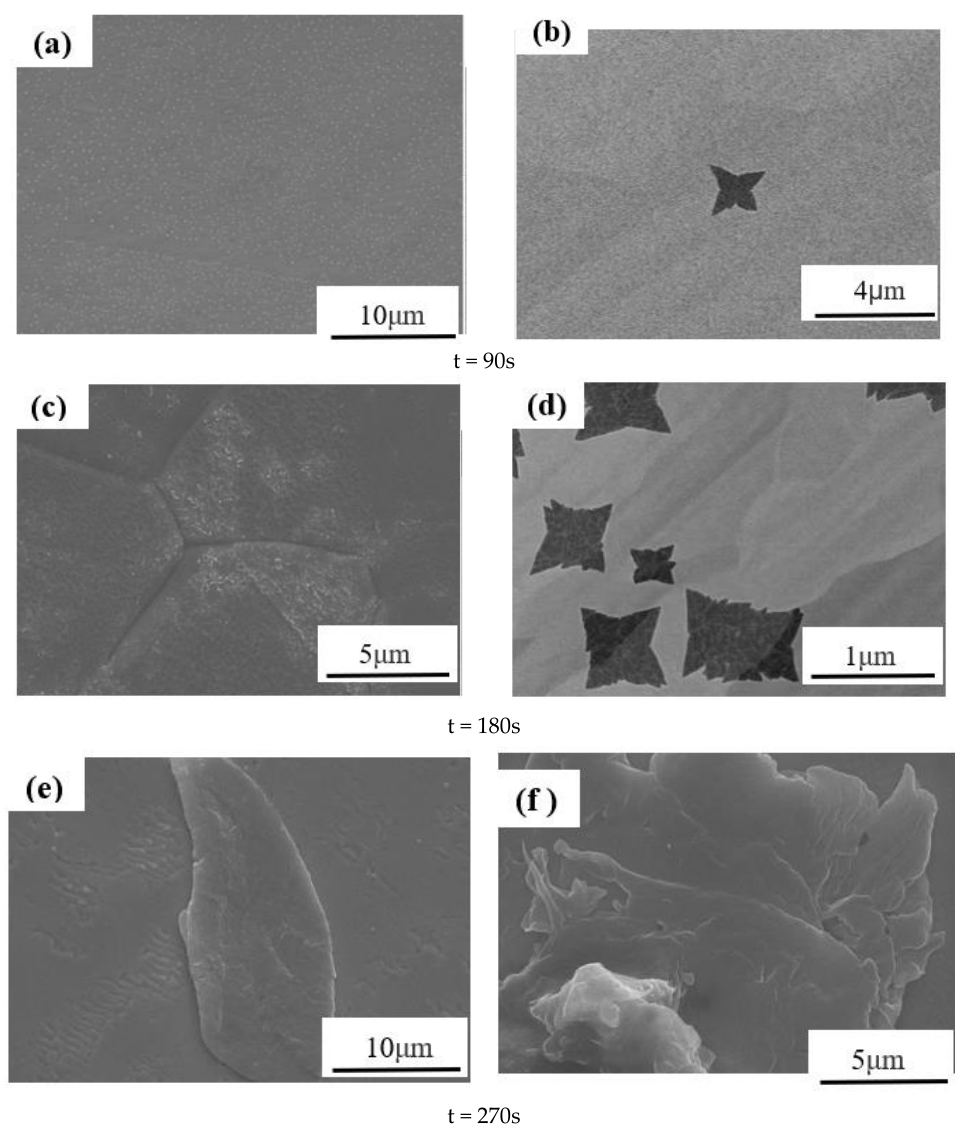
Figure 14. Scanning electron microscope (SEM) image of graphene on copper: ( a , c , e ) without the Tesla valve structure; ( b , d , f ) with the Tesla valve structure.